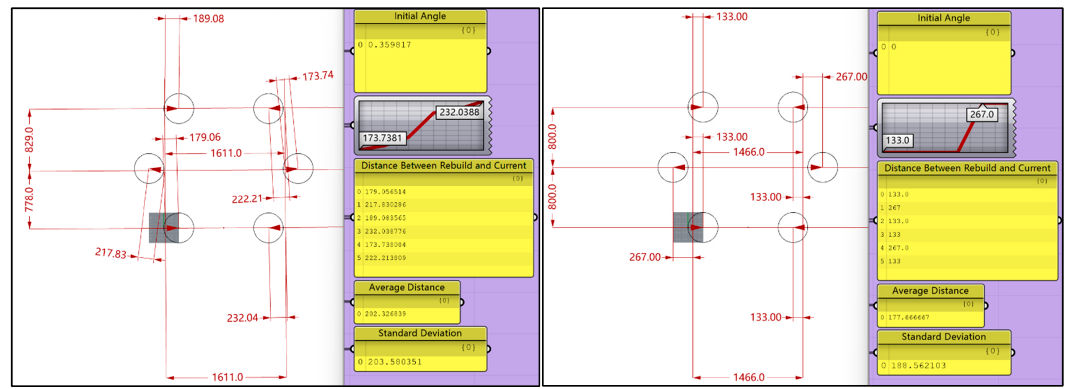
Figure 15. Verification of six asymmetric columns (the disordered axes on the left, the result axes on the right).